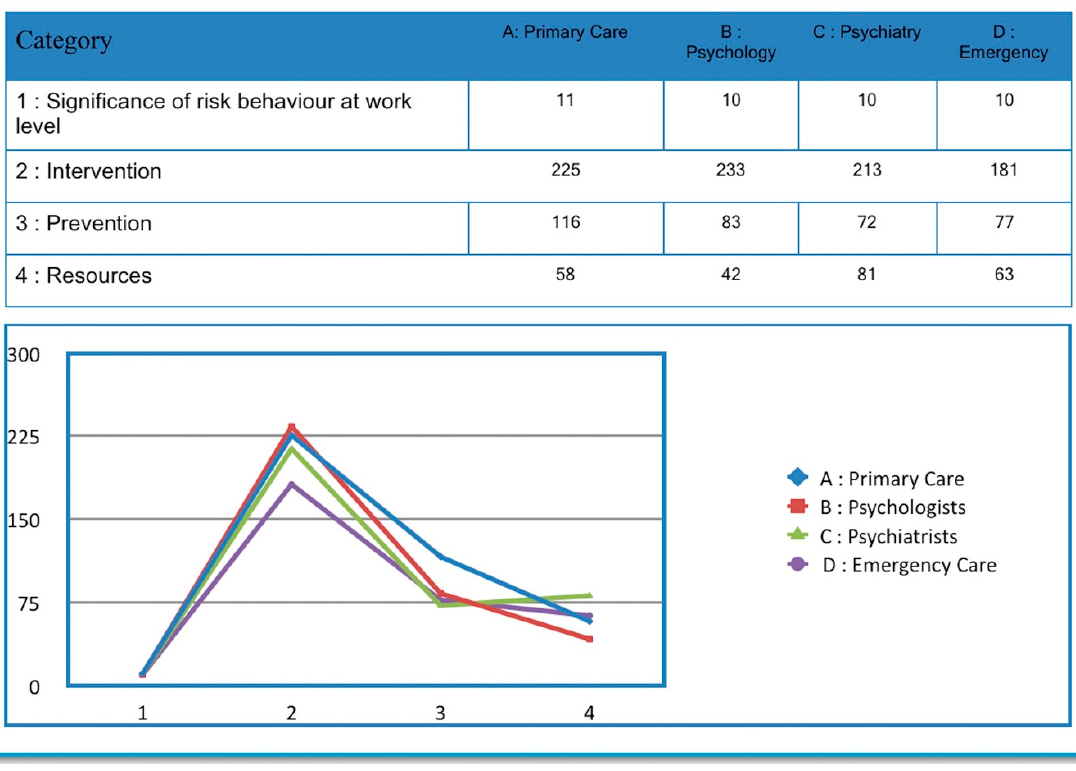
Figure 3. Coded references.